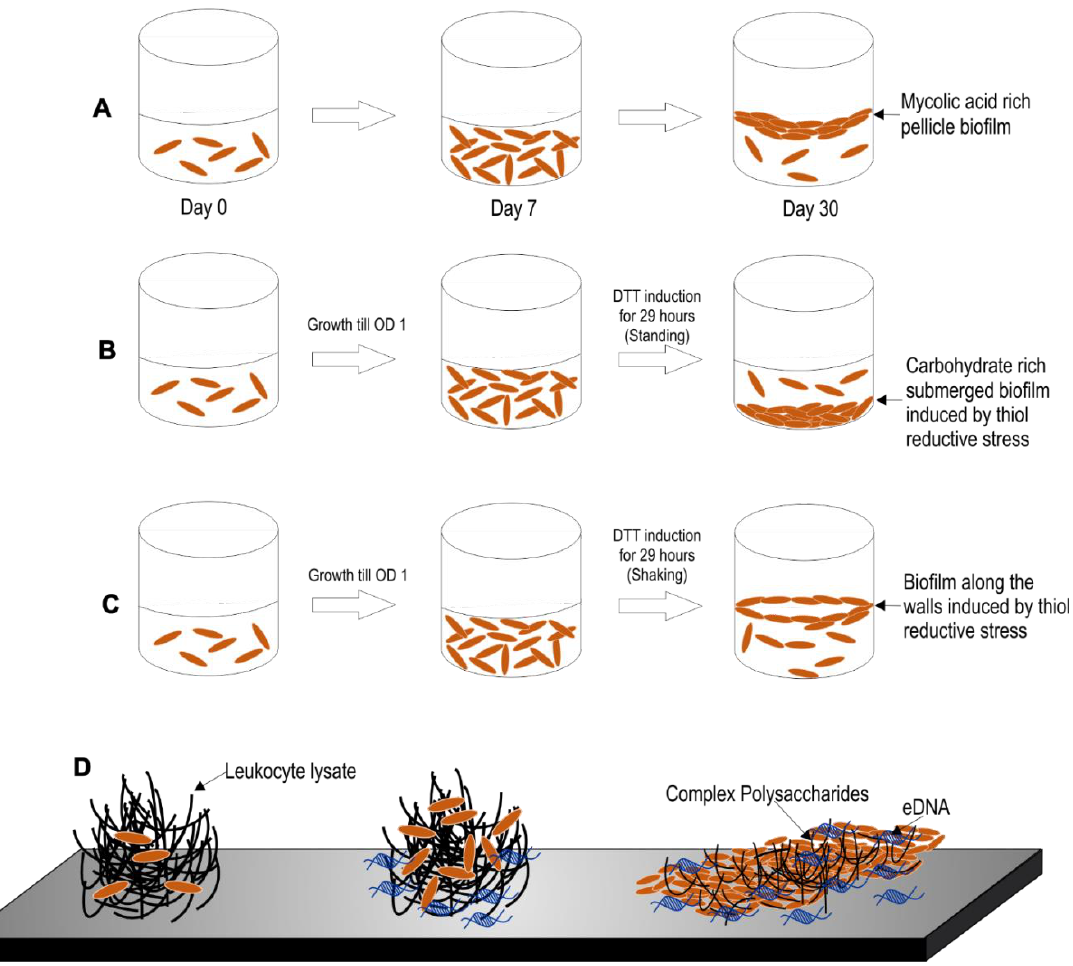
FIGURE 2: Different models of biofilm formation in M. tuberculosis . (A) Pellicle biofilm model of M. tuberculosis . The pellicle biofilm ma- tures through several stages of development in around 5-7 weeks. These biofilms are rich in free mycolic acids. (B-C) Thiol reductive stress induced biofilm of M. tuberculosis. This model is induced by thiol reductive stress generated by reduced DTT. This polysaccharide rich biofilm of Mtb takes around 29 hours to develop. Keeping the culture flask at standing position generates a biofilm that attaches to the bottom surface of the flask (B) , whereas shaking of the culture leads to biofilm formation at the liquid-air interface (C) . (D) Leukocyte lysate induced biofilm model of M. tuberculosis . This eDNA rich biofilm of Mtb takes around 7 days to develop. This model may depict the biofilms formed inside the granuloma, wherein leukocyte lysate is available due to cell lysis induced by Mtb